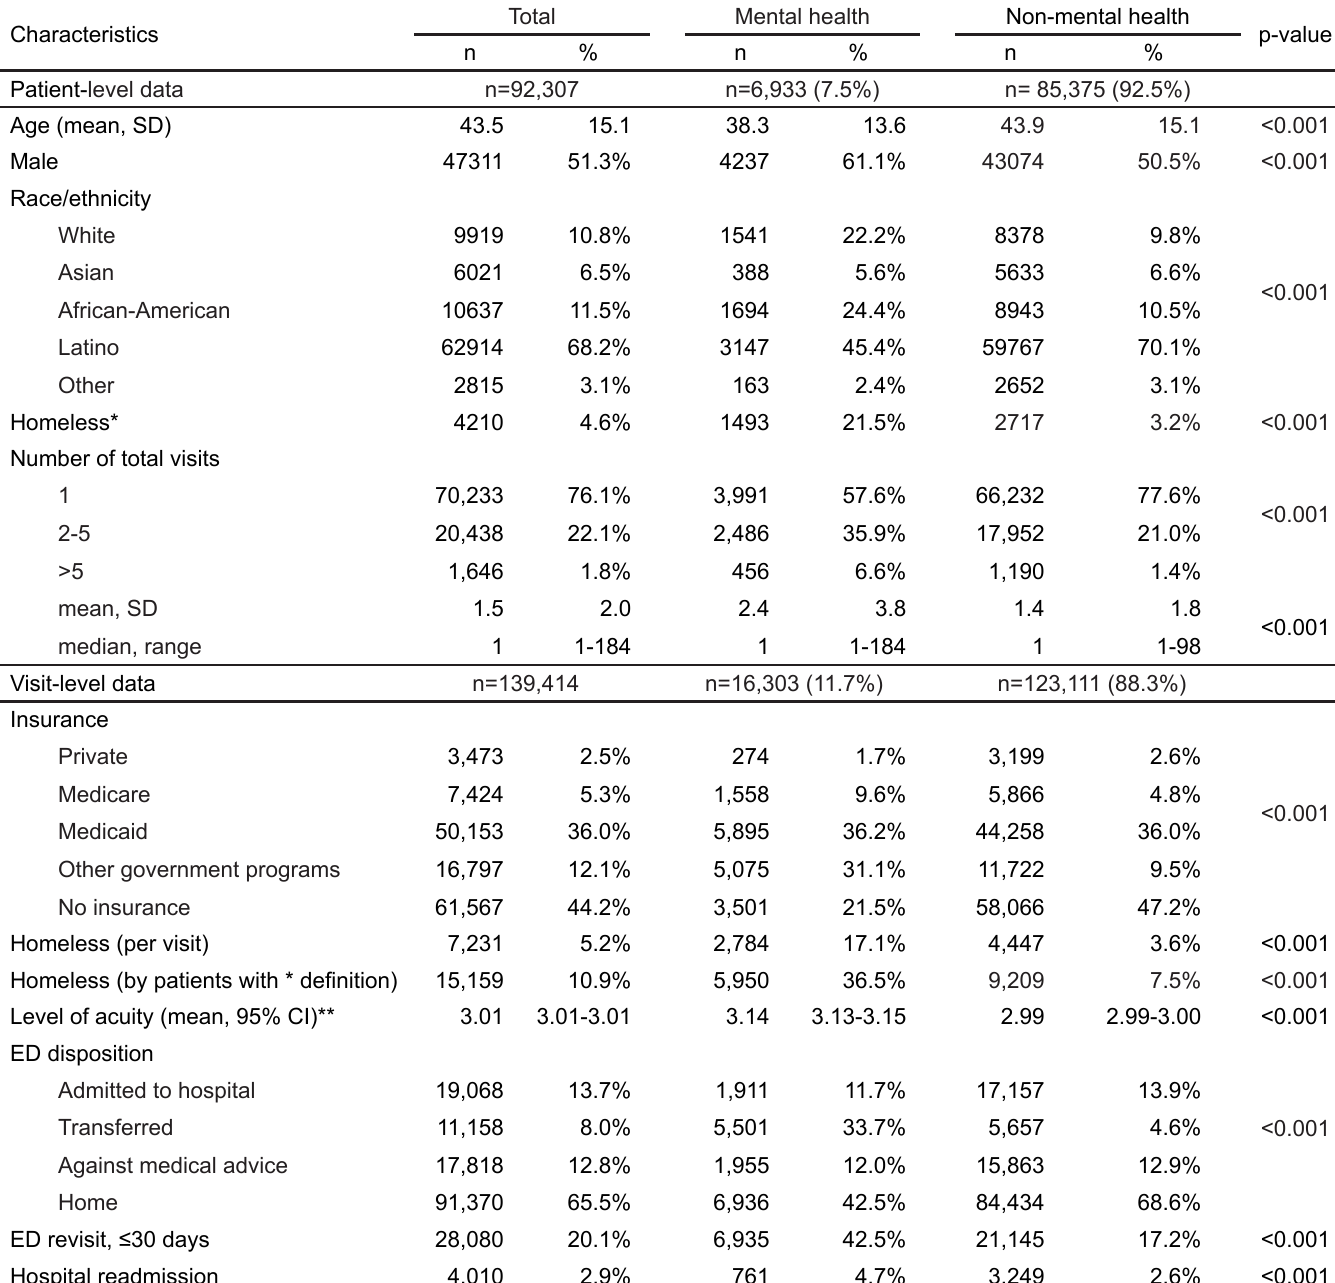
Table 1. Characteristics of patient-level and visit-level data, by mental health status.